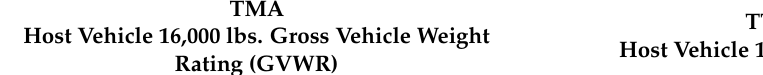
Table 1. Pros and cons of utilizing TMAs and TTMAs